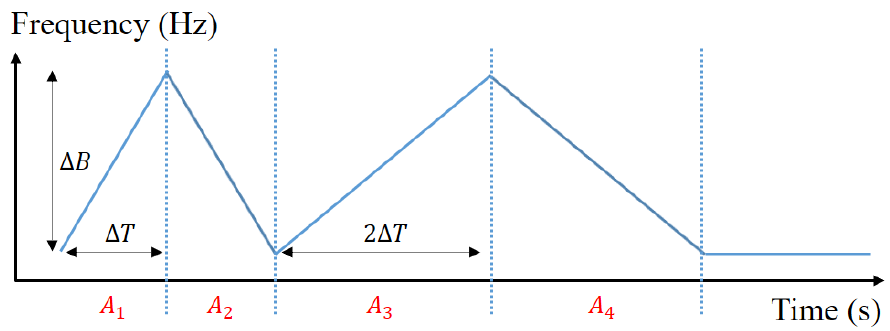
Figure 5. Frequency change of the waveform over